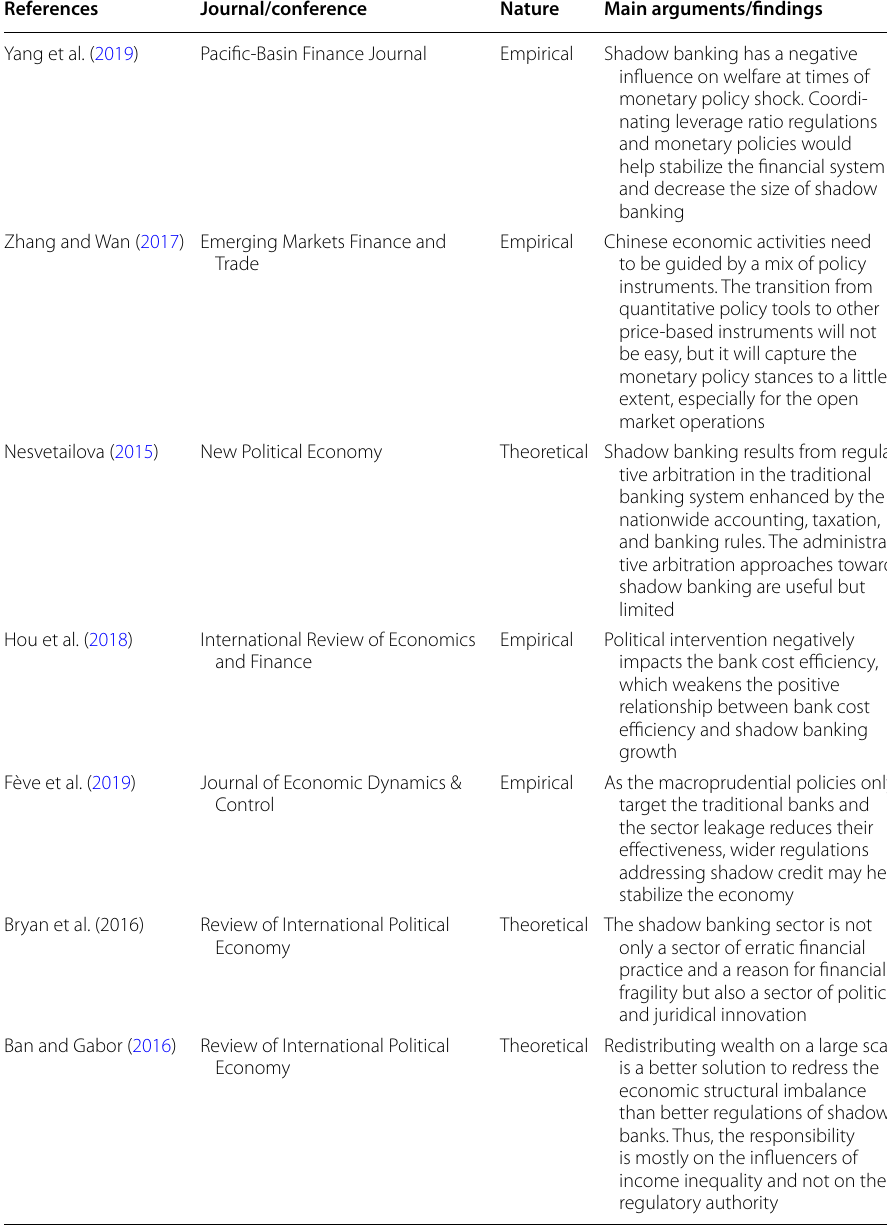
Table 6 Key literature on policy and political issues of